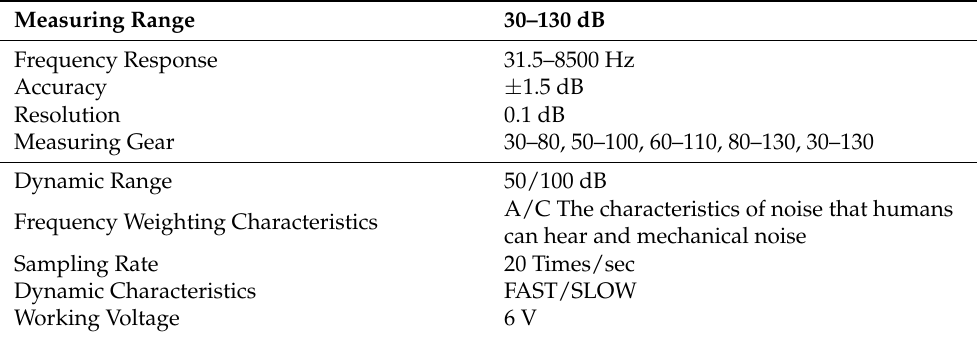
Table 5. Online digital noise meter parameters.